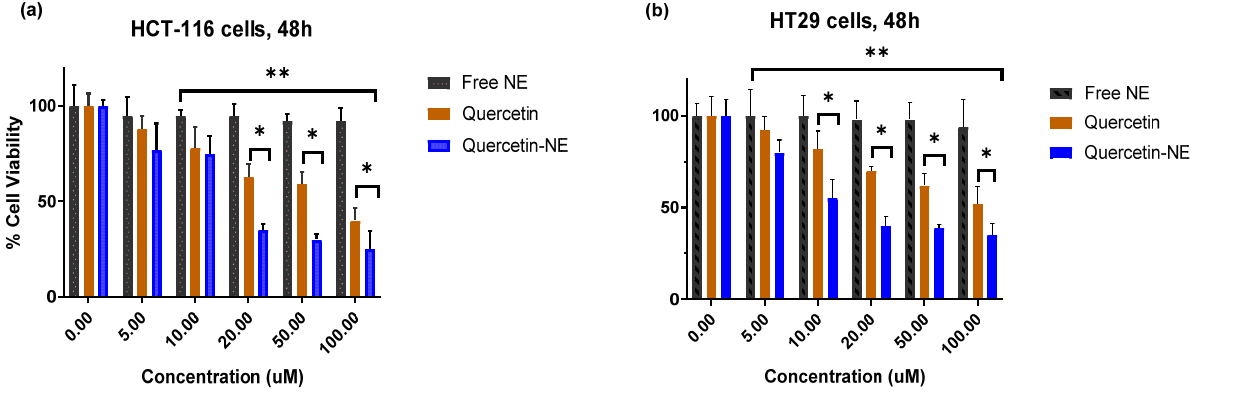
Figure 6. Cell viability of QR anticancer drug treated with 5–100 µ M QR, QR-NE, and free NE up to 48 h for ( a ) HCT-116 and ( b ) HT-29 colon cancer cell lines. Results indicated that formulation inhibited CRC cell viability in a dose-dependent manner of QR-NE compared to free drugs, while empty NPs are nontoxic. The twofold lower IC50 value of QR-NE indicates the superior anticancer effect of nanoparticle-based formulations. Results are expressed as mean ± SD ( n = 3). * p < 0.01, ** p < 0.001 based on two-way ANOVA followed by Sidak’s multiple comparisons test.